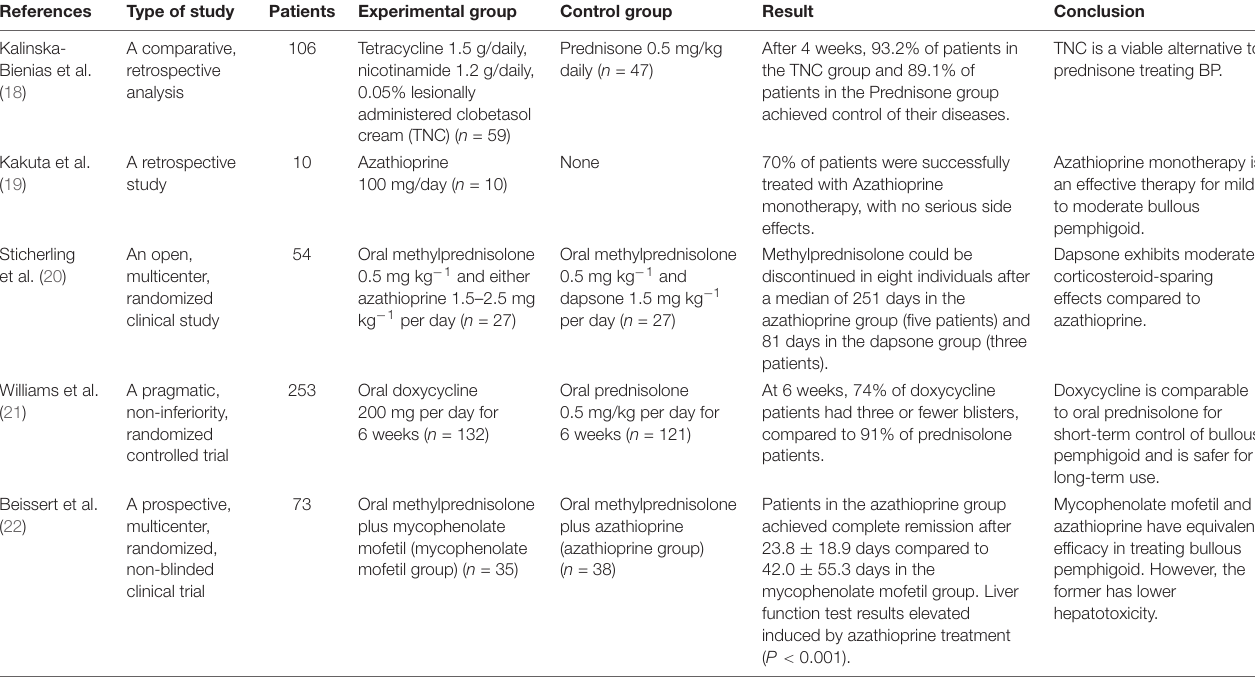
TABLE 1 | Summary of clinical studies on adjunct and alternative hormone therapies for bullous pemphigoid